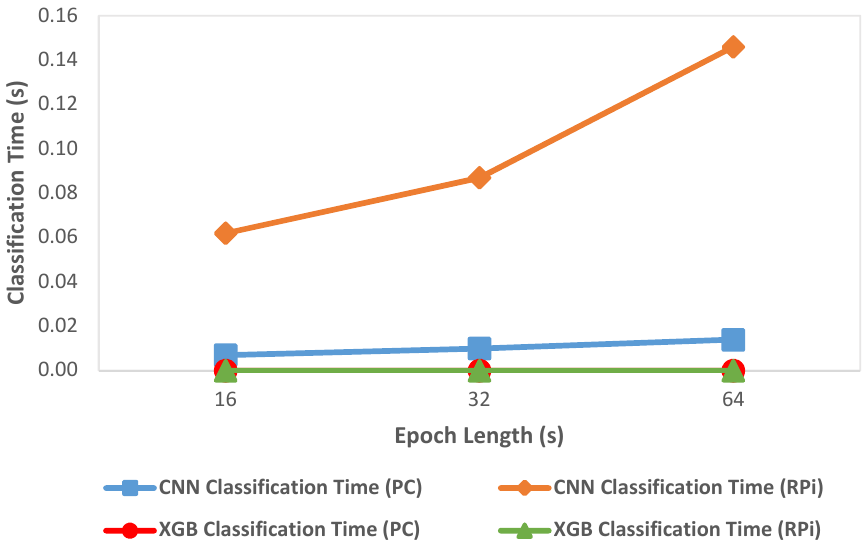
Figure 6. Variation of classification time with epoch length.